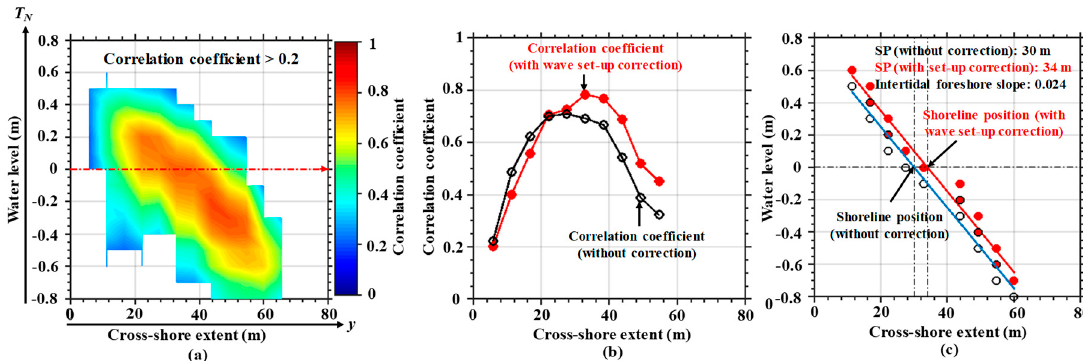
Figure 17. An example of the mTWM detected beach profile at x = − 49 m with a corrected wave set-up during 17–30 June 2005. ( a ) The distribution of correlation coefficients between different tidal signals (–0.8 to 0.8 m) and cross-shore positions (0 ≤ y ≤ 80 m). ( b ) The distribution of correlation coefficients for cross-shore positions at a water level 0.0 m (without and with corrected wave set-up). The maximum correlation is established at y = 33 m for a corrected wave set-up. ( c ) The intertidal beach profile determined by linear regression. The shoreline position is defined at water level 0.0 m.